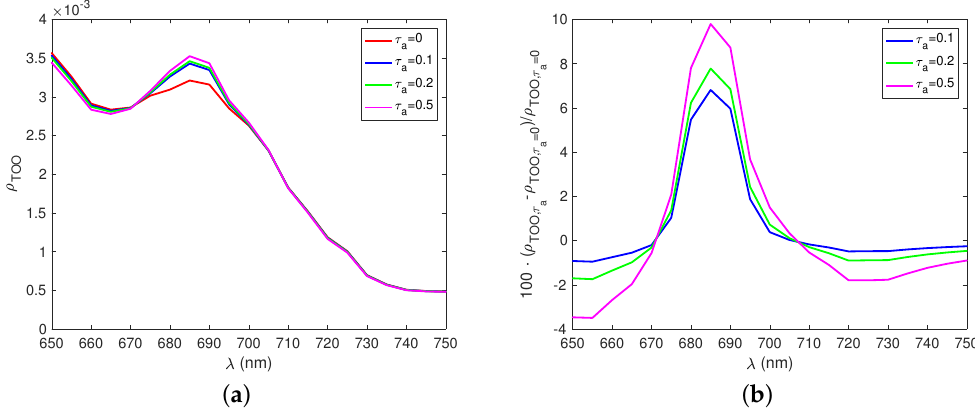
Figure 4. ( a ) The nadir viewing reflectance at TOO as a function of wavelengths for different aerosol optical depths. [Chla] = 10.0 mg/m 3 and the solar zenith angle is 30 ◦ . ( b ) The percentage differences of fluorescence signals for different aerosol optical depths.